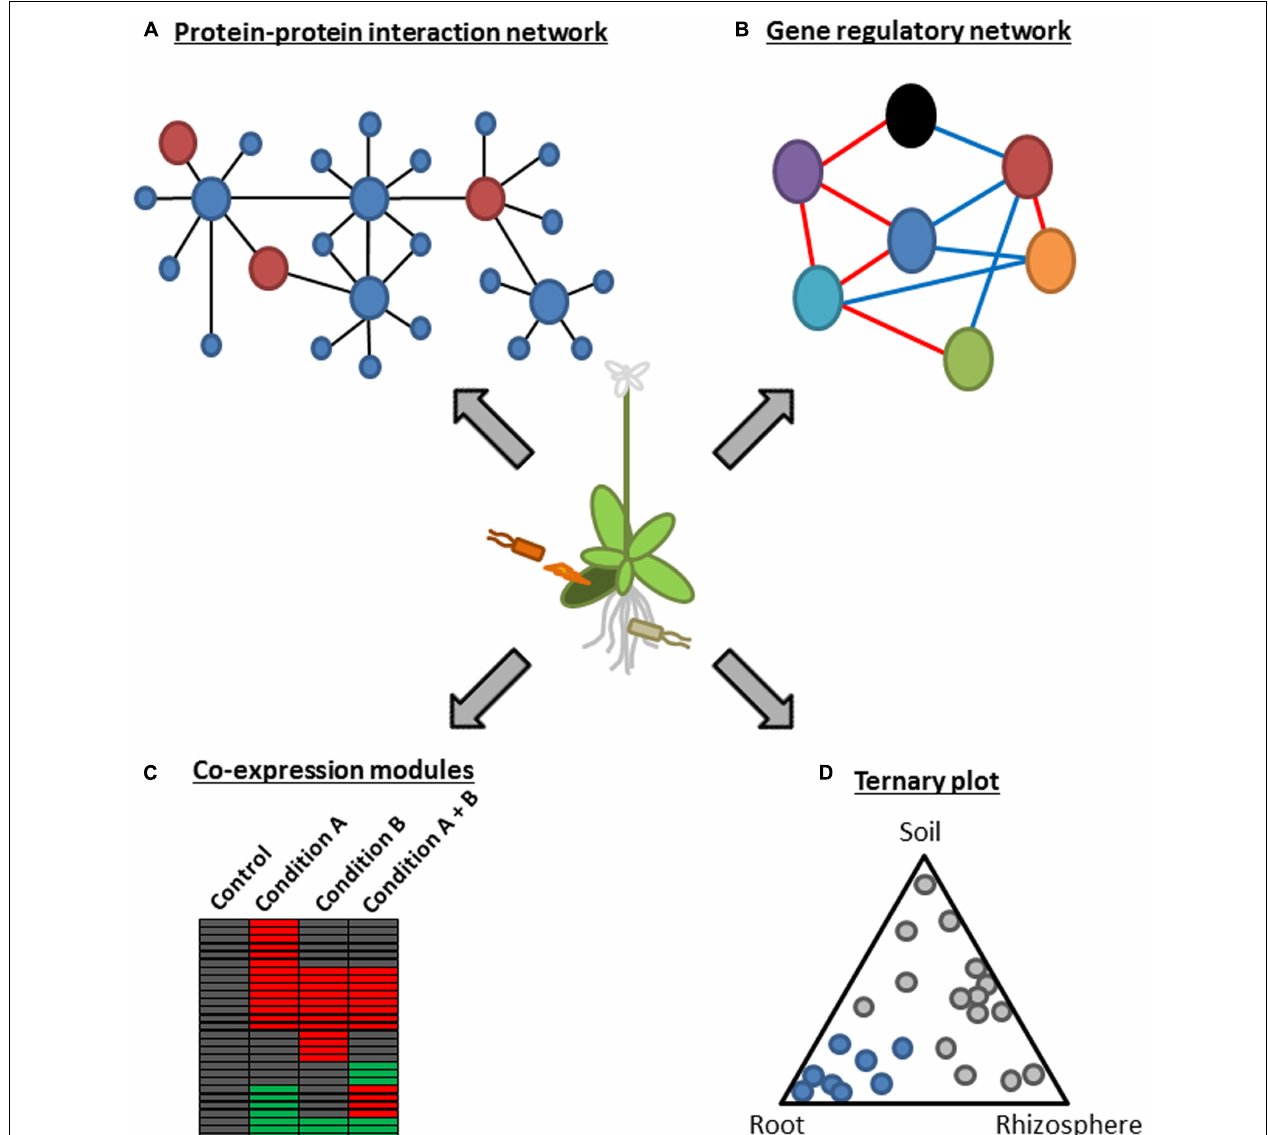
module analysis is useful to visualize behavior of a system under certain conditions. As an example, co-regulated genes under different conditions are visualized in the heatmap. Red and green boxes indicate up-regulated and down-regulated genes in a certain condition, respectively. This approach was used in Zou etal. (2011), Atkinson etal. (2013), Prasch and Sonnewald (2013), and Rasmussen etal. (2013). (D) A ternary plot is used to show influence by three variables on composition. This example depicts bacterial OTUs whose relative abundance changes according to the three compartments, soil, rhizosphere, and root. Blue circles mark OTUs enriched in the root compartment. This approach was used in Bulgarelli etal. (2012) and Lundberg etal.